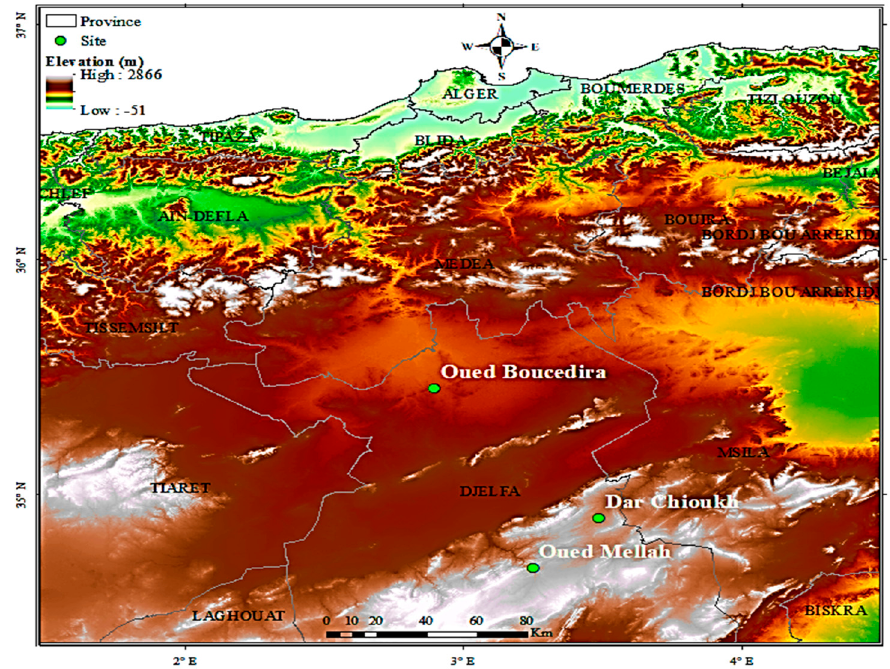
Figure 1. The research region and chosen sites including Oued Boucedira, Dar El Chioukh, and Oued Mellah.